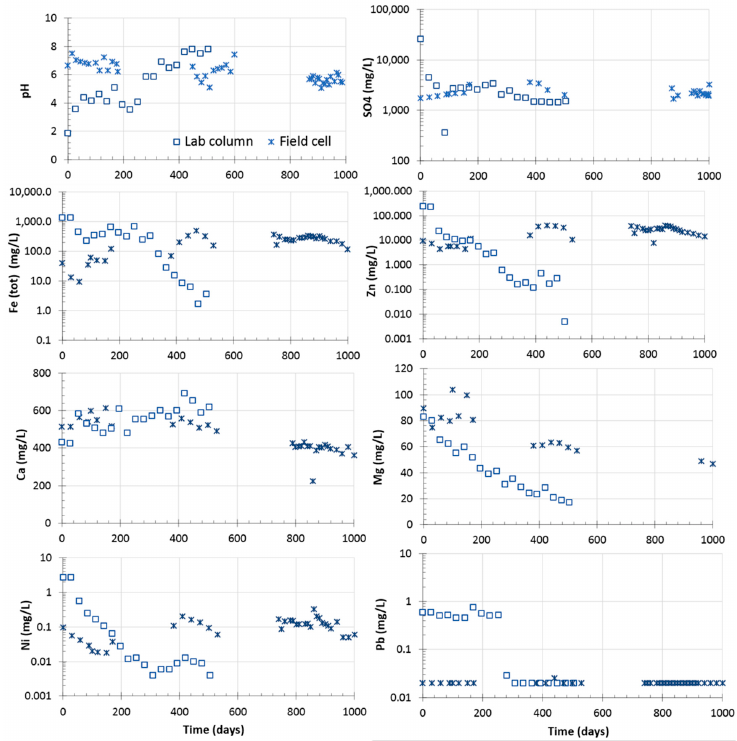
Figure 9. Evolution of leachate quality for the CCBE column and field cell.